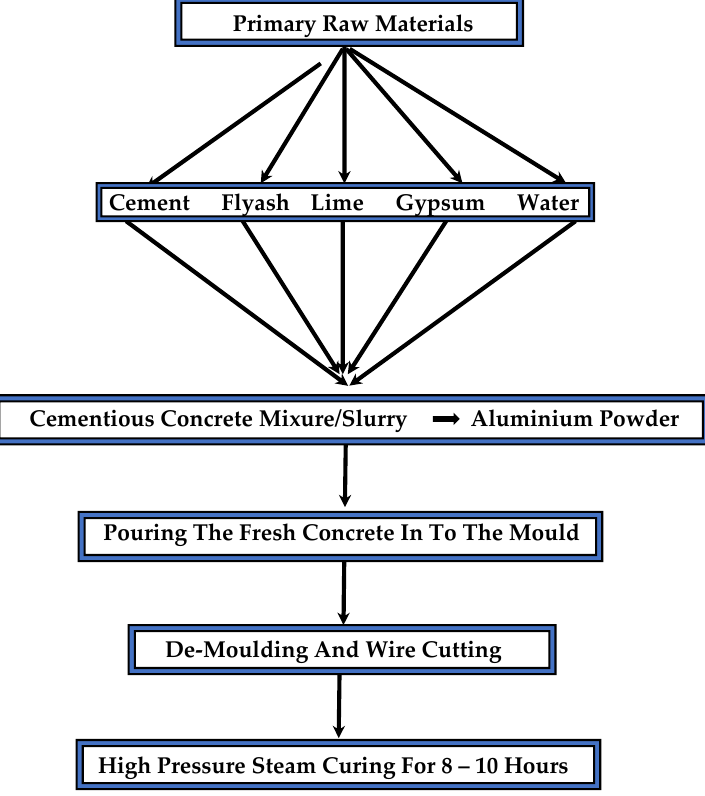
Figure 9. Flow chart of the AAC Specimen Preparation Process